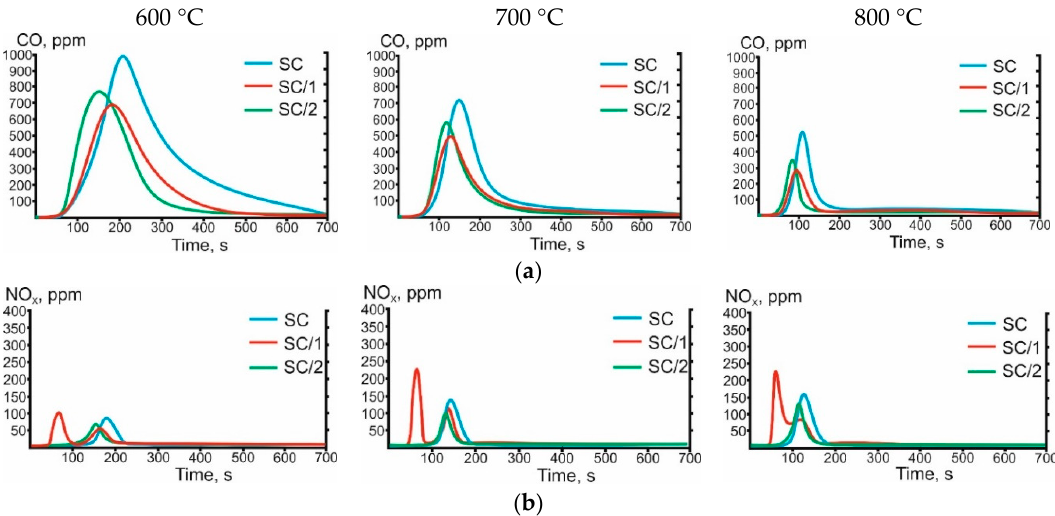
Figure 8. The concentration profiles for the gaseous products formation during the combustion of the studied semi ‐ coke samples at different temperatures of heating medium: ( a ) СО ; ( b ) NO x .